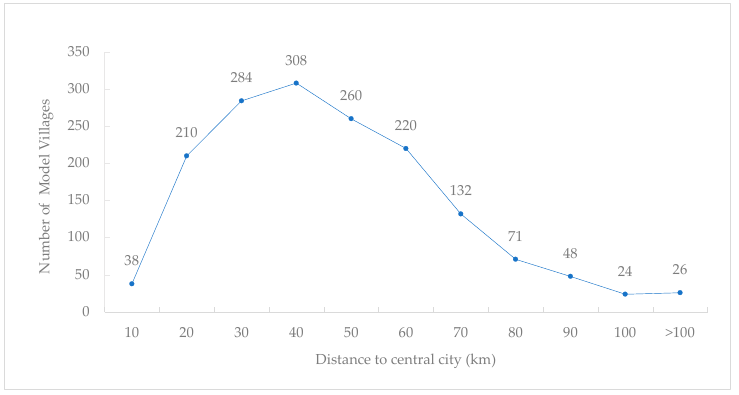
Figure 5. Curves of the number of rural revitalization model villages and the distance to central city in the YRD.